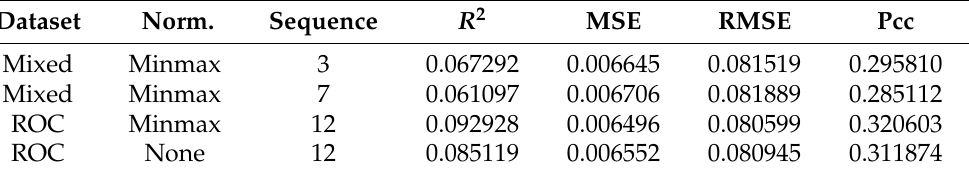
Table 8. Top 2 best metric performers in LSTM Bi-direction regressor.